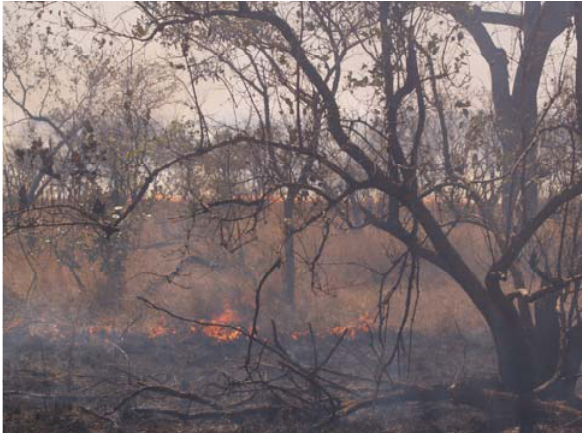
Figure 5: Burning grassland sample plot during the overpass of TET-1